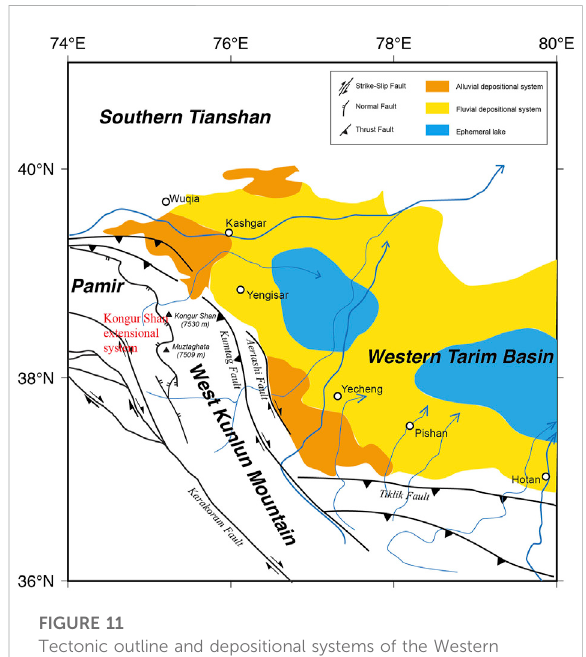
FIGURE 11 Tectonic outline and depositional systems of the Western Tarim Basin and its surroundings during the Pliocene (Robinson et al., 2004; Wei et al.,